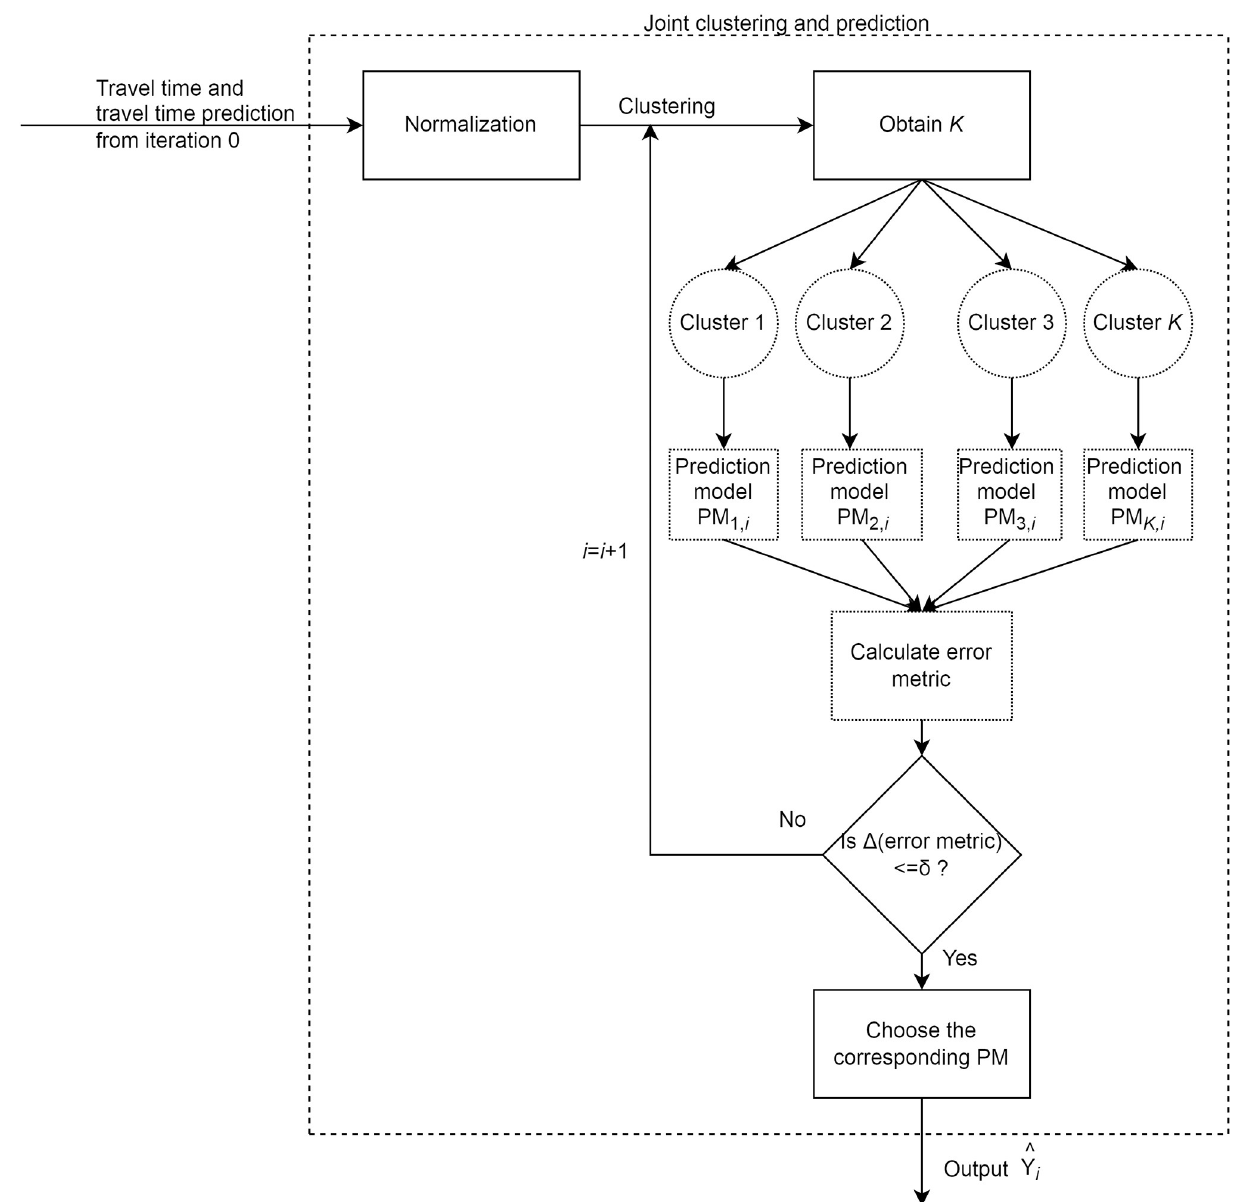
Fig 1. Joint clustering and prediction